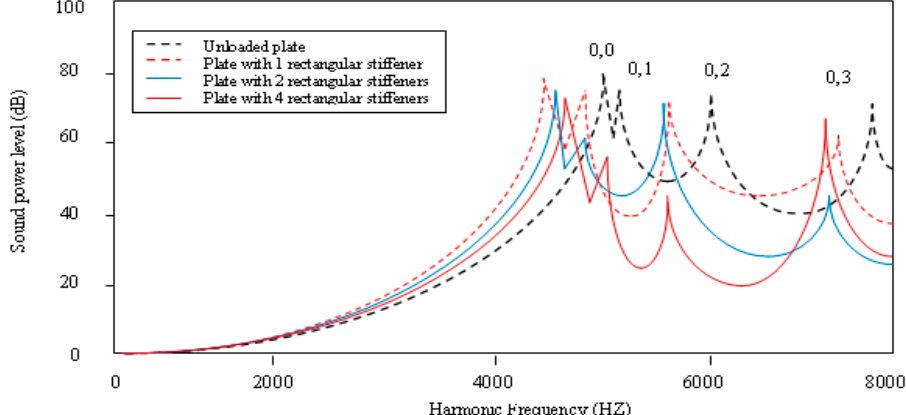
Figure 18. Numerical comparison of sound power level for annular plate having parabolic increasing decreasing thickness variations (Case III) for different combinations of rectangular stiffener patches for taper ratio T x = 0.75.